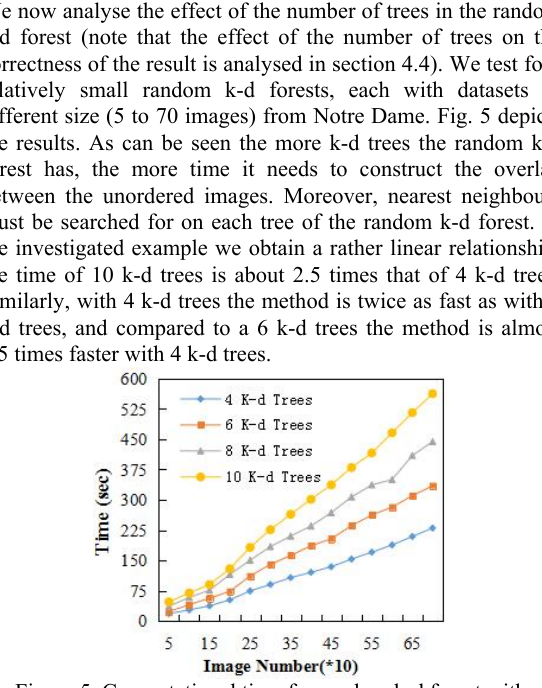
Figure 5. Computational time for random k-d forest with different